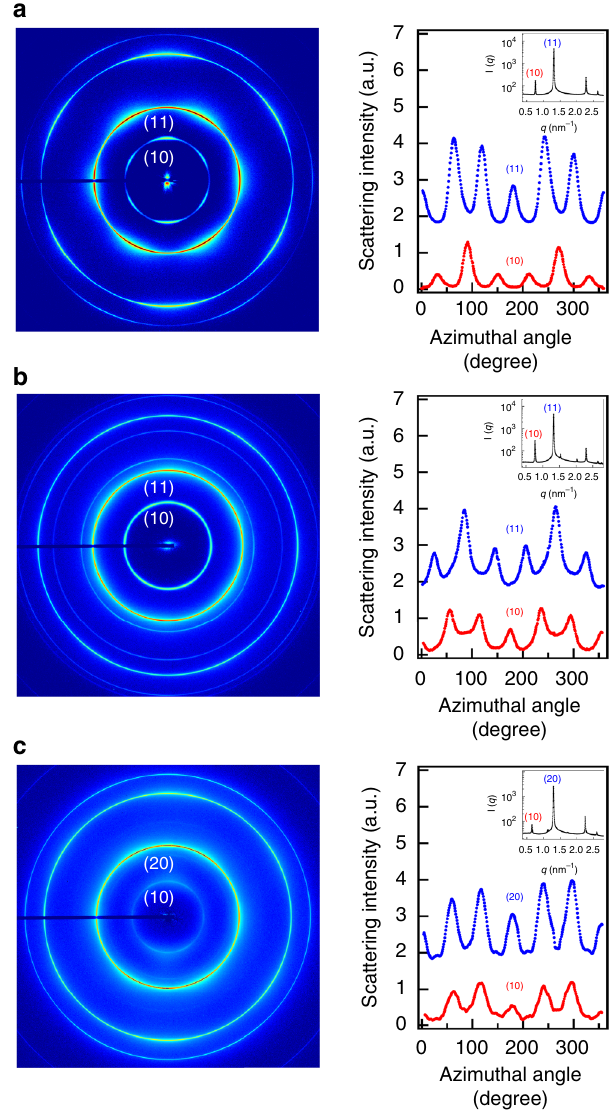
Fig. 7 Shear-induced alignment of binary superlattices. SAXS measurements along the tangential direction for the samples of a p -C 14 TVB/C 12 E 5 /water (10/45/55), b p -C 10 TVB/C 12 E 5 /water (10/45/55), and c p -C 10 TVB/C 12 E 5 /water (5/45/55). The azimuthally averaged intensities along the (10) and (11) re fl ections (which make the peak position ratio of 1: √ 3) for AB 2 type structure and those along the (10) and (20) re fl ections (which make the peak position ratio of 1:2) for AB 3 type structure are shown on the right together with the 1D SAXS intensities ( inset